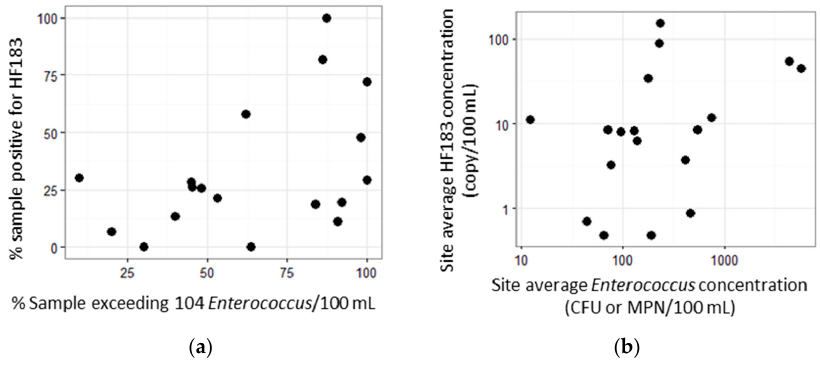
Figure 5. Ranking site by HF183- vs. Enterococcus -based metrics during summer dry weather: ( a ) frequency of HF183 detection versus frequency of Enterococcus spp. exceedance; ( b ) site average HF183 concentration versus site average Enterococcus spp. concentration. HF183-based metrics are defined as in Figure 3. Frequency of Enterococcus exceedance is defined as % samples with more than 104 Enterococcus per 100 mL. Site average concentration of Enterococcus spp. is defined as geomean at the site. CFU and MPN denote colony forming units and most probably number,